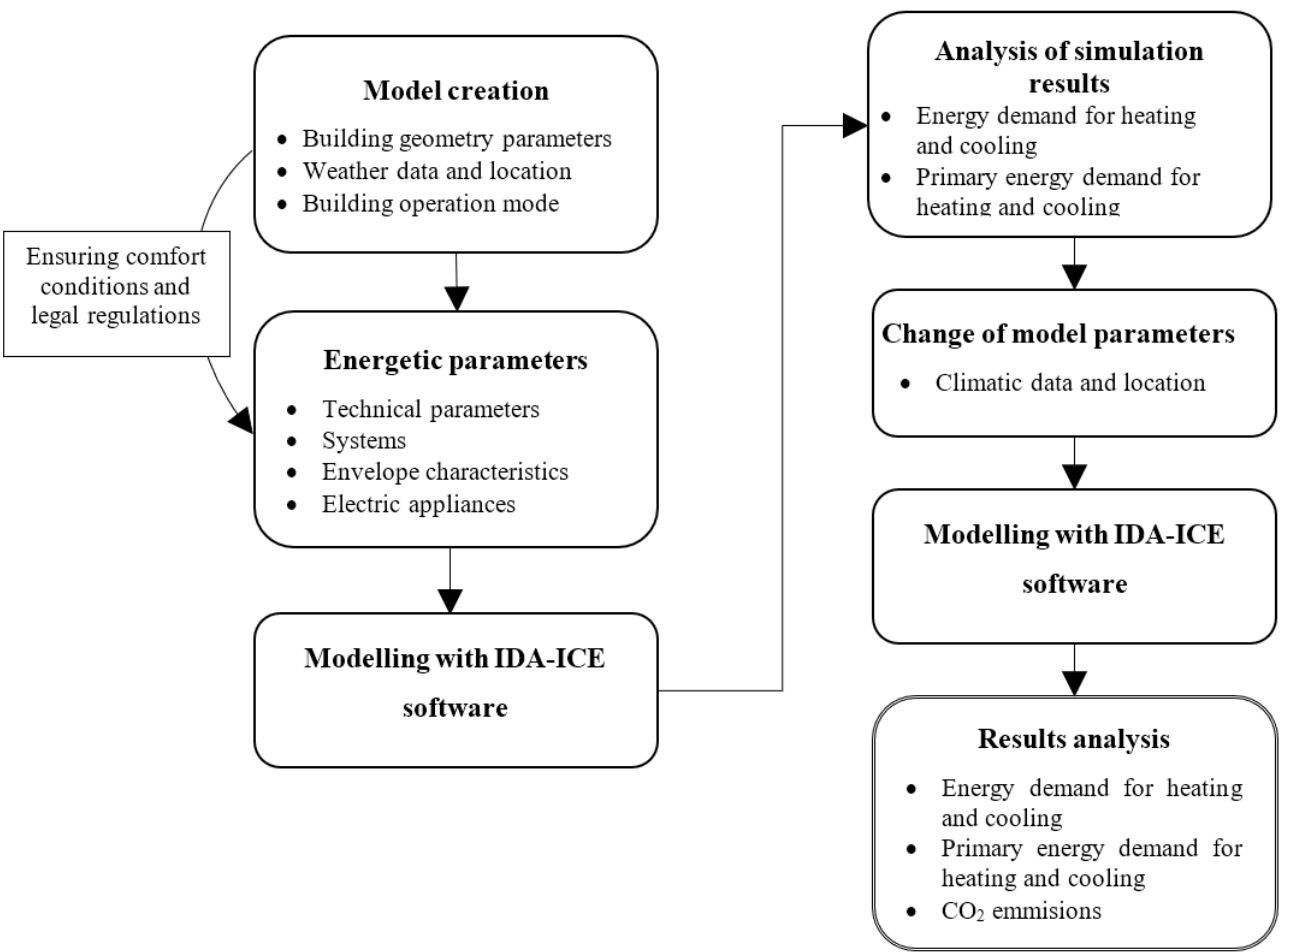
Figure 2. Study method (adapted by the authors in reliance on [29,30]).